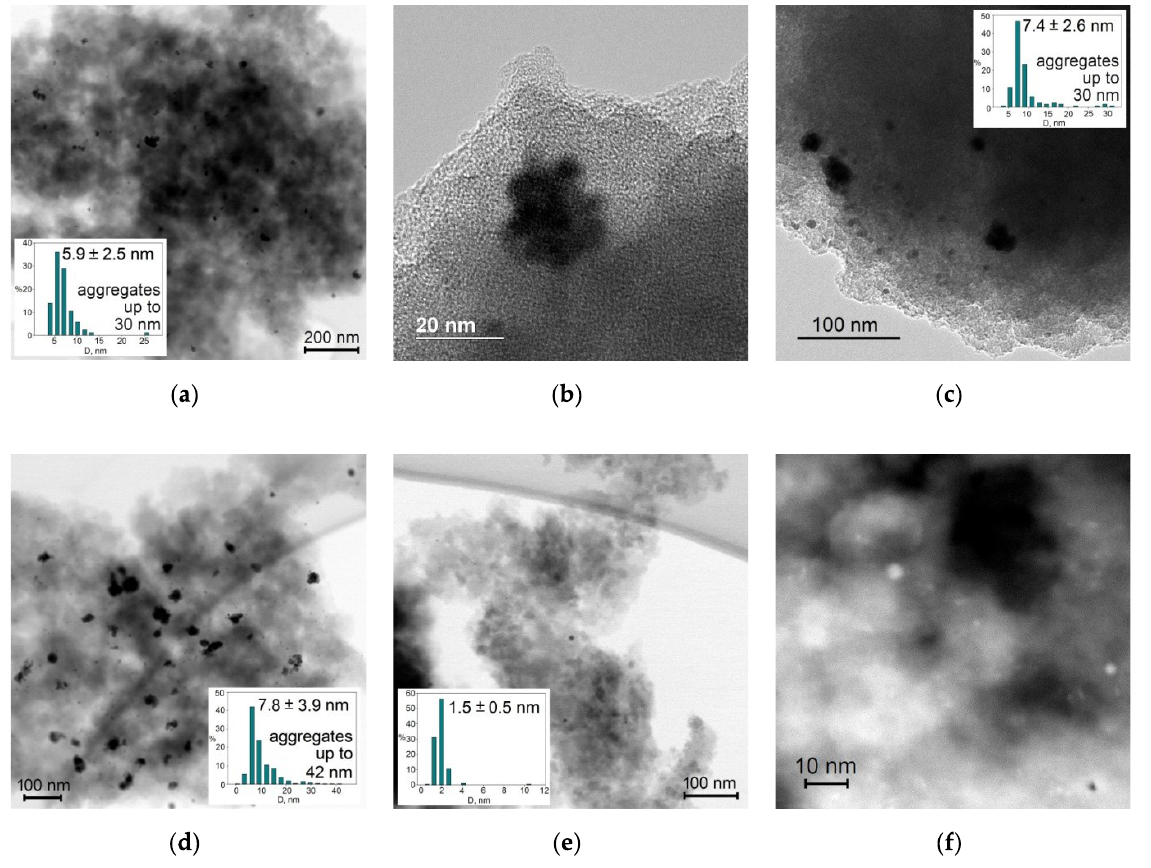
Figure 6. S/TEM images of catalysts taken after the reaction of MBY hydrogenation: ( a ) Pd/C7 (scale 100 nm), ( b ) Pd/C7 (scale 20 nm), ( c ) Pd/PS (scale 100 nm), ( d ) Pd/OF3 (scale 100 nm), ( e ) Pd/OF2 (scale 100 nm), and ( f ) HAADF STEM of Pd/OF2 (scale 10